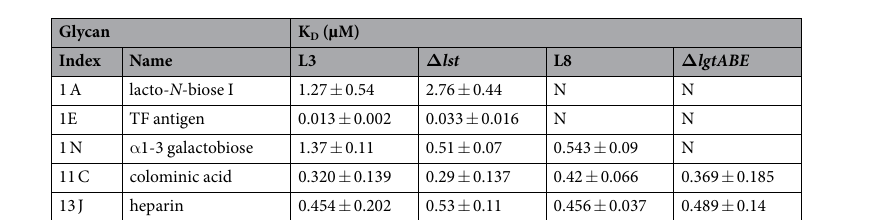
Table 3. SPR analysis of LOS mediated glycointeractions. N: No concentration dependent binding observed within the instrument’s detection range. L3, Δ lst , L8 and Δ lgtABE refer to lipooligosaccharide (LOS) structures purified from MC58 wild-type, Ȼ 3, Ȼ 3 Δ lst , and Ȼ 3 Δ lgtABE strains, respectively (Table 1 and Fig. 2). Refer to Supplementary data S2 for sensorgrams for each individual